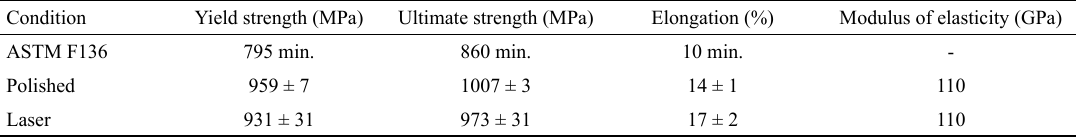
Table 2. Tensile mechanical properties of the studied material. Condition